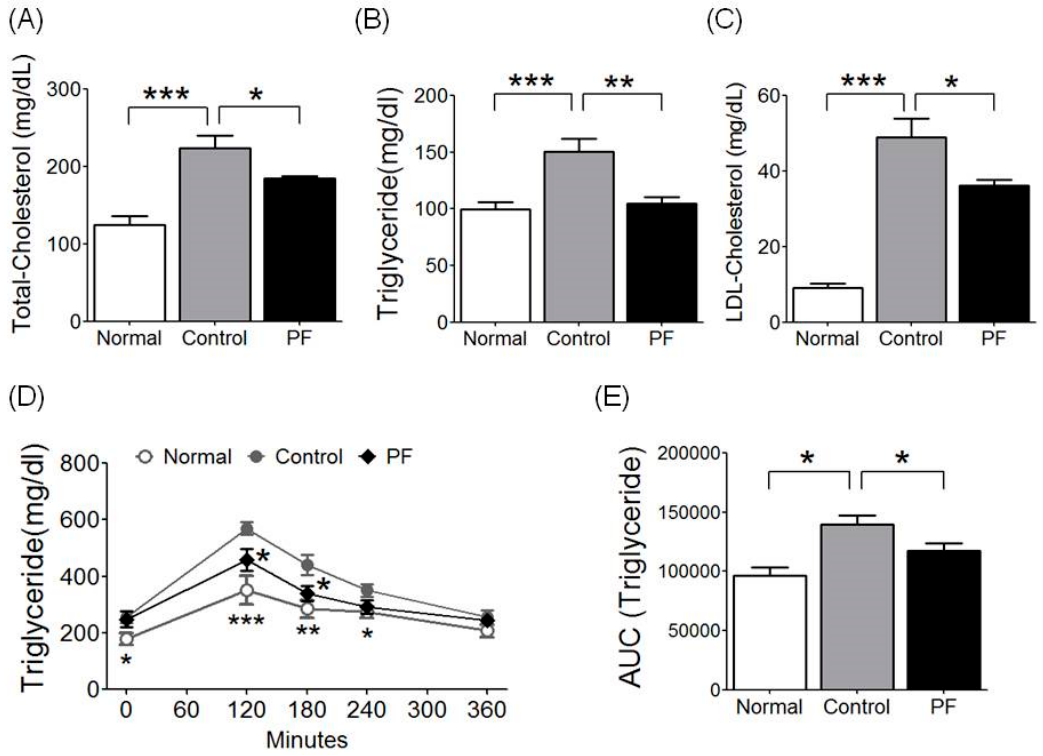
Figure 3. Effects of PF on ( A ) serum total cholesterol, ( B ) triglyceride, ( C ) low-density lipoprotein (LDL) cholesterol, and ( D and E ) oral fat tolerance test (OFTT) and area under curve (AUC), respectively. n = 6 in each group. Data shown are the mean ± SEM. * p < 0.05, ** p < 0.01, *** p < 0.001, compared with HFD.